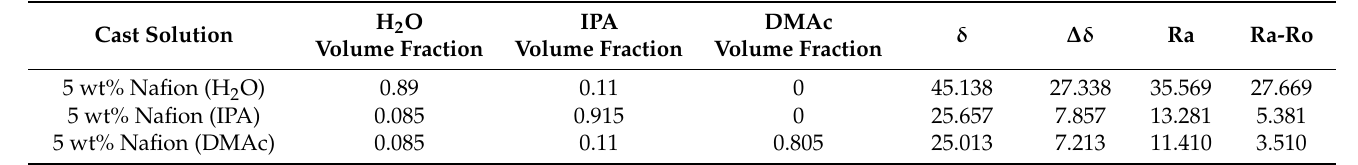
Table 1. The solvent composition and property of 5 wt% cast solution for D-H 2 O, D-IPA, and D-DMAc.